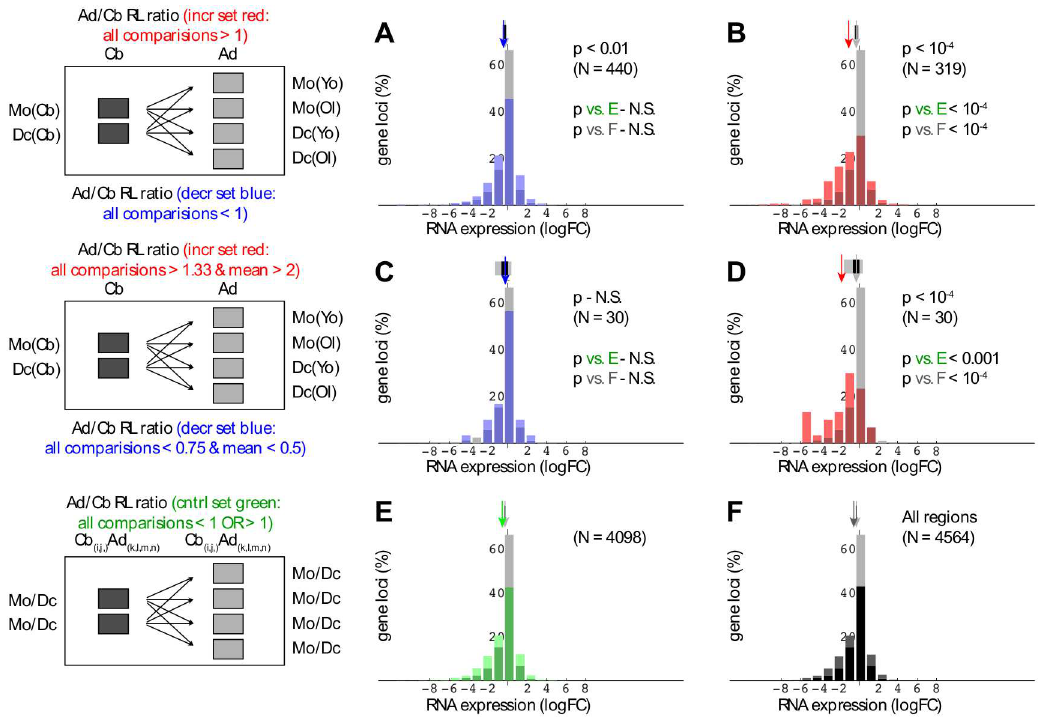
Fig 6. Associations between region span and postnatal dendritic cell gene expression change. Analysis identical to that in Fig 5, except dendritic cell (DC) RNA-seq data (minimum logCPM = -4.62) are shown. Plotting conventions are as in Fig 3.